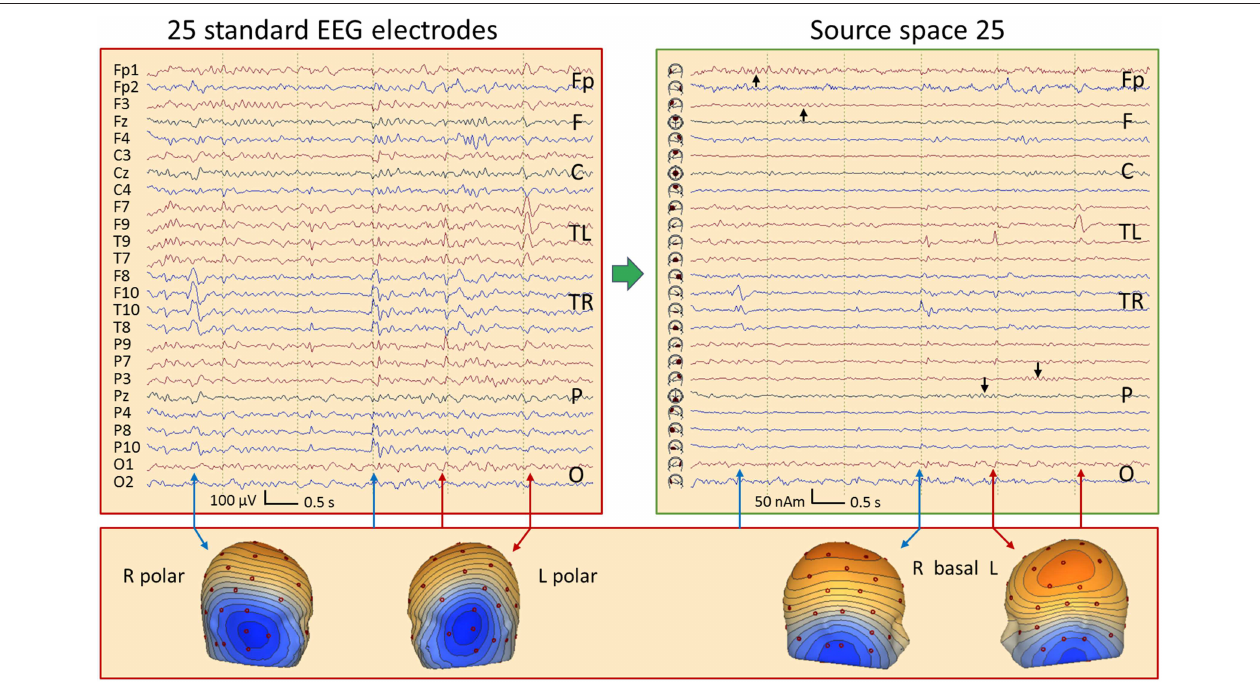
FIGURE 11 | Comparison of the scalp EEG at 25 standard electrodes in average reference (left) with standard source space 25 (right) in a case with bitemporal spiking. Filter settings optimized for IED review: 2–35Hz, zero-phase characteristic ( 26). Right (blue arrows) and left (red) polar spikes are seen at the beginning and end of the displayed 6-s EEG segment, most prominent in the inferior channels F10 and F9. In the middle of the segment, IEDs with more complex distributions are seen on the scalp. Transformation into source space 25 provides a much clearer picture: The polar temporal lobe spikes can be identified immediately in the source waveforms below F10 and F9. Basal temporal spikes are seen on the right below T10 (blue) and on the left (red) below T9 (2 spikes emerging clearly, the 1st immediately after the right basal spike below T10). In source space, the temporal spikes appear considerably more focal and emerge much more clearly from the EEG background. In addition, overlap from frontal and parietal EEG rhythms (black arrows) is strongly